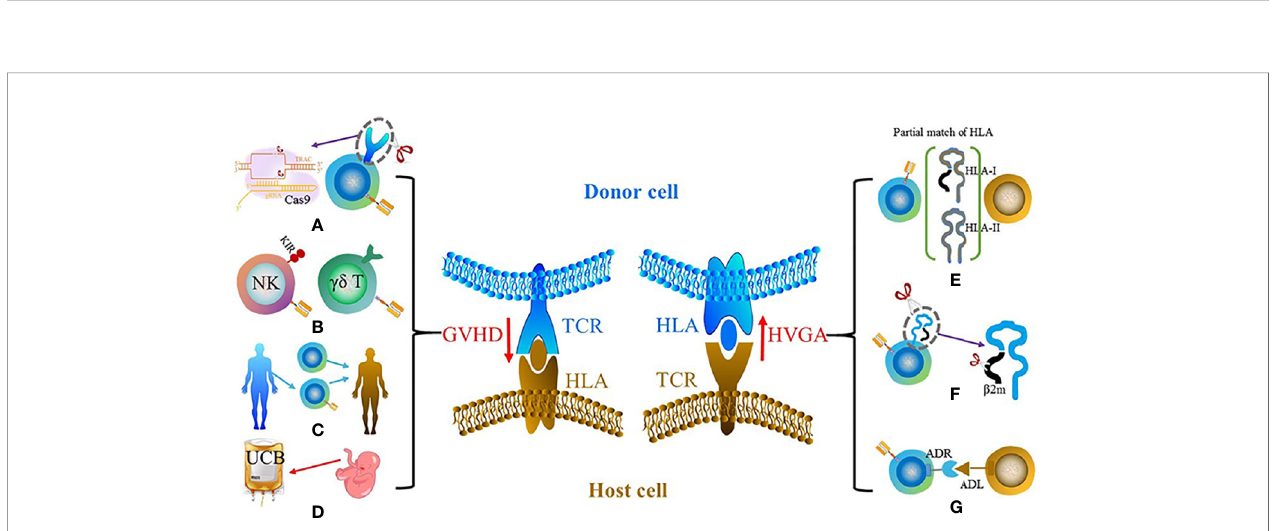
FIGURE 2 | Two key barriersfor UCtherapy: GVHD (left) andHVGA (right).The main solutionsfor GVHD include (A) using gene-edited ab T cells such as theknockout of ab TCR using CRISPR-Cas9; (B) using other types of cells insteadof ab T cells such as NK celland gd T cell; (C) using donor-derived CAR cells; (D) using cellswith different sources insteadofPBMCs such as UCBs. The potential solutionsfor HVGA include (E) using HLA-matched donor,especially HLA-A and HLA-B that belongto HLA-I and HLA-DR that belongs to HLA-II; (F) using gene editing to knockout HLAofdonor cells; (G) grafting an ADR that recognizes the ADL on host cells.